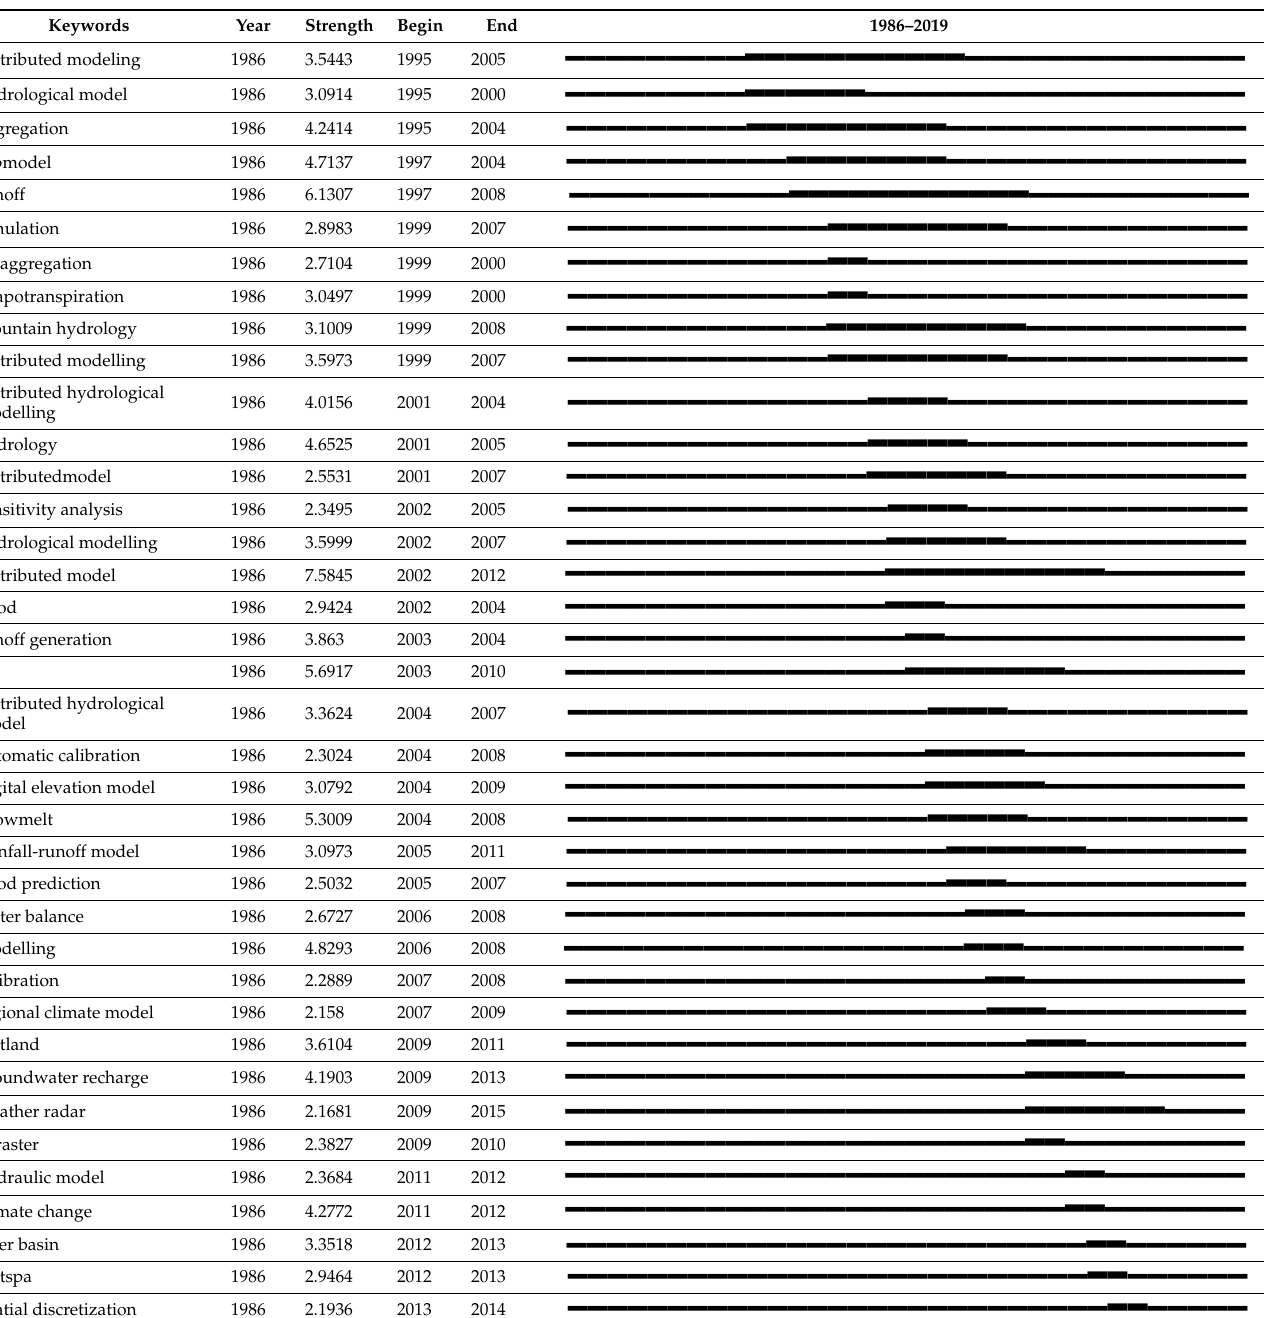
Table 5. Top 52 keywords with the strongest citation bursts.